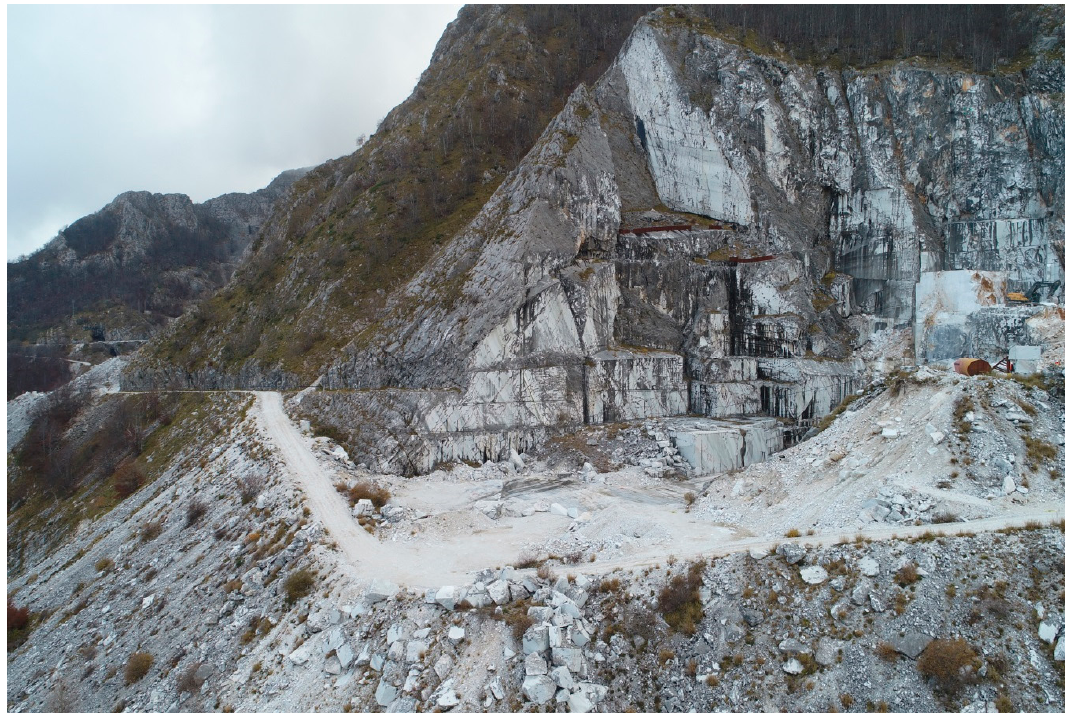
Figure 1. View of the Piastrone open pit quarry.